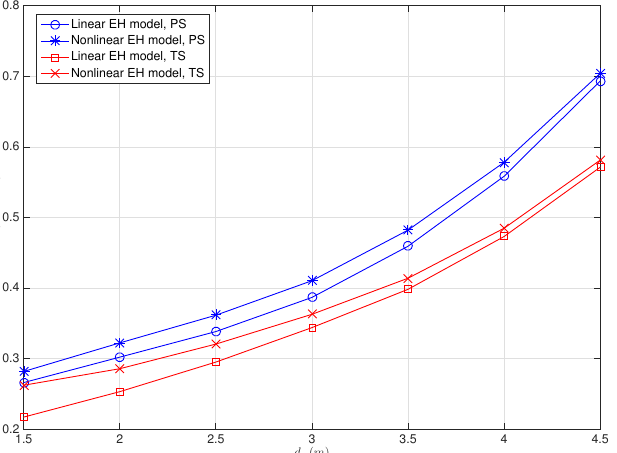
Figure 6. Maximum achievable rate versus d sc for SWIPT multi-relay cooperative system with PS and TS schemes when P s / N 0 = 20 dB, K R = 0 dB, β = 2, d sc + d cd = 6